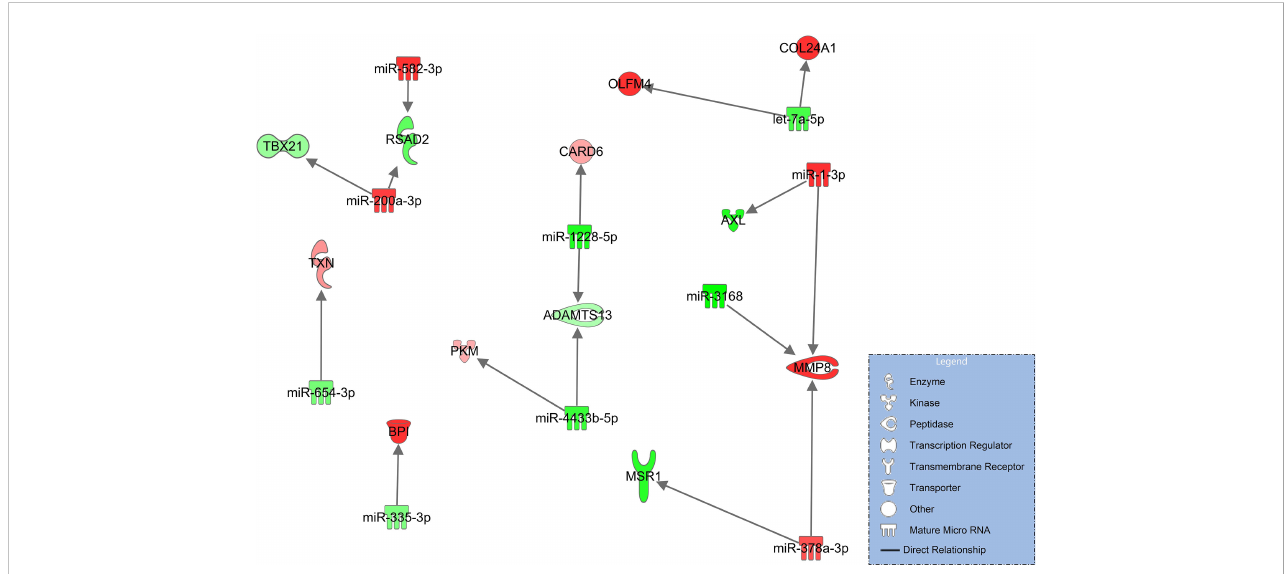
FIGURE 5 Immune and endothelial cell signaling in COVID-19 pneumonia compared to patients progressing to COVID-ARDS. Upregulated molecules are shown in red and downregulated in green. Network is based on experimentally observed fi ndings and highly predicted